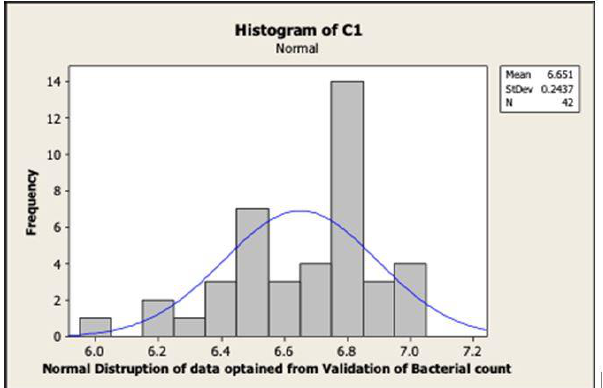
Fig.1: Normal distribution at confidence level 95% for Bacterial count.